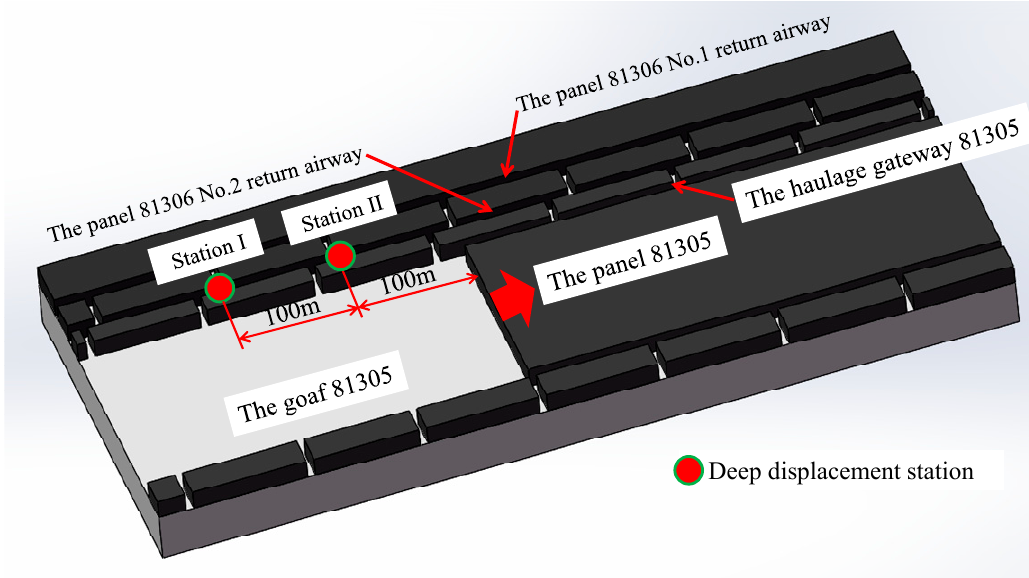
Figure 10. Layout scheme of high-density deep displacement monitoring of roof.